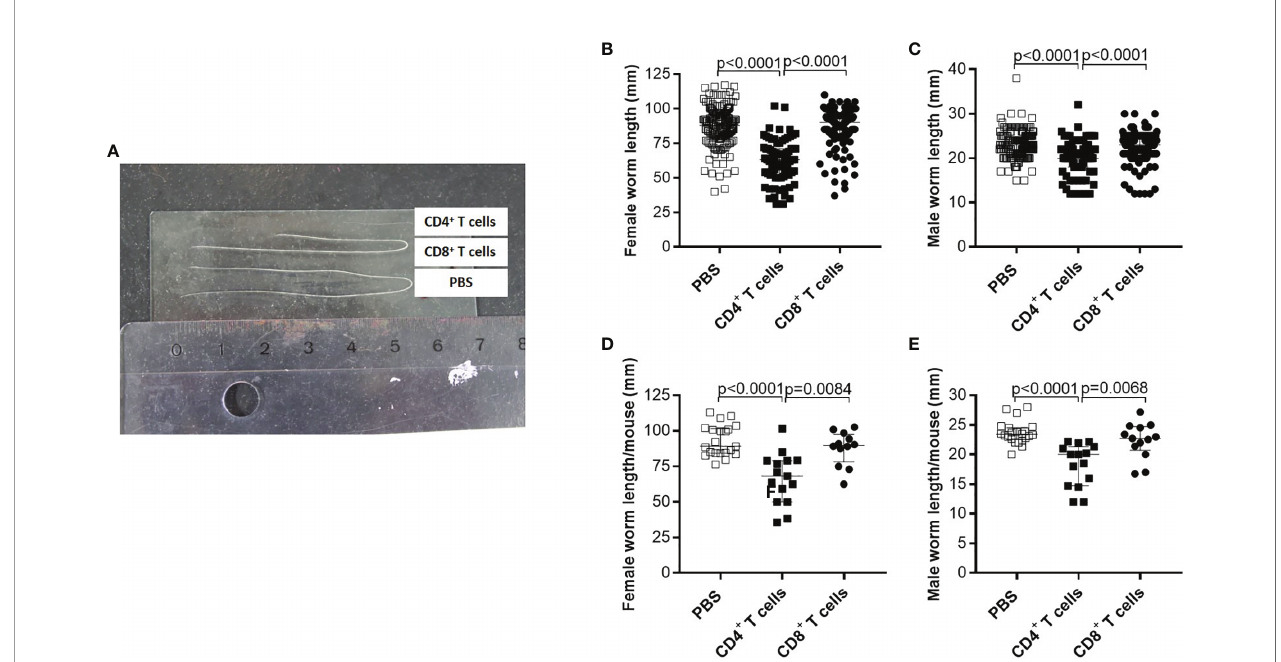
FIGURE 2 | Adoptive transfer of naïve CD4 + T cells impair worm growth. On day 72 p.i., RAG2IL-2R g -de fi cient C57BL/6 mice that were adoptively transferred with CD4 + or CD8 + T cell from naïve C57BL/6 donor mice were analysed for (A) worm length to assess individual (B) female and (C) male worm length and (D) female and (E) male worm length per mouse. (B – E) Graphs show dot blots with median and interquartile ranges and are pooled from four independent experiments including no adoptive transfer (PBS; n=25) and adoptive transfer of CD4 + (n=21) and CD8 + T cell (n=17) into RAG2IL-2R g -de fi cient C57BL/6 mice. Signi fi cant differences between the groups were determined by Kruskal-Wallis-test followed by a Dunn ’ s multiple comparison